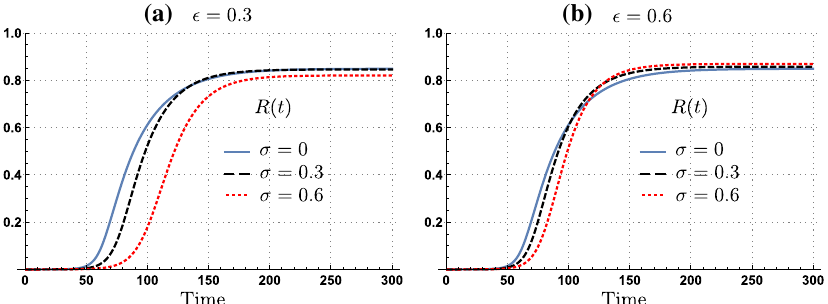
Figure 2. Time evolution of the proportion of recovered population for scenarios with 0%, 30%, and 60% of asymptomatic cases under adaptive behavior model. The impact of the asymptomatic subpopulation on the attack rate depends upon its relative infectiousness. (a) Shows that increments of the asymptomatic subpopulation having low infectiousness ( ǫ = 30% ), decreases the attack rate. (b) Shows that increments on the asymptomatic cases having high infectiousness ( ǫ = 60% ), increases the attack rate. Parameters τ = 14, ν = 0.1, C I = max C t , l = 1 and ρ = 0.25 .